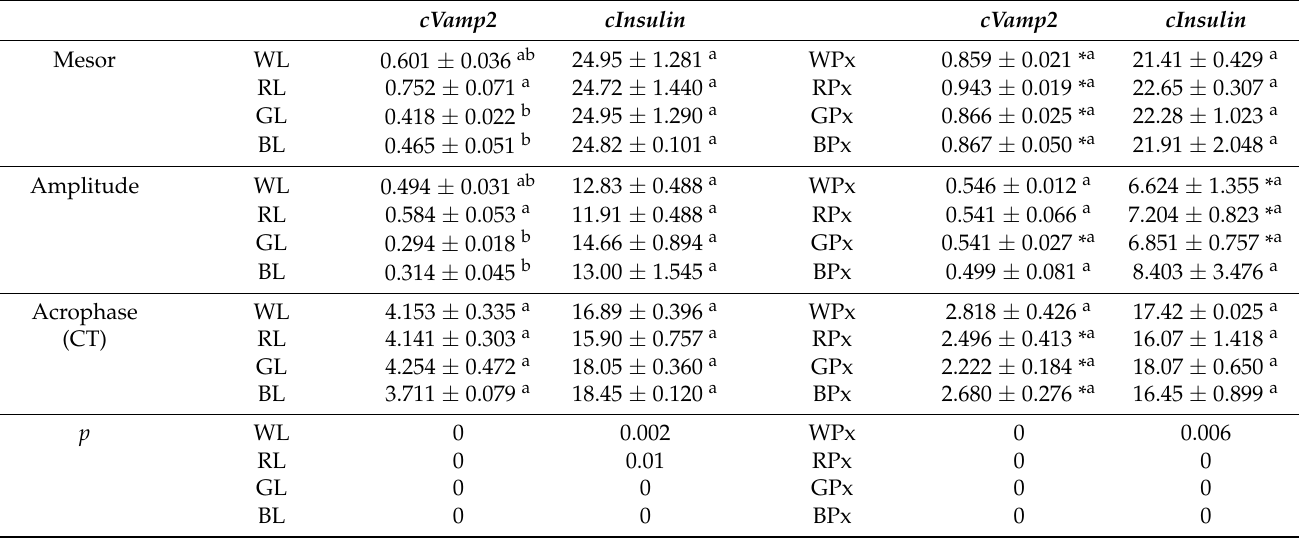
Table 3. The daily temporal difference parameters and circadian rhythm parameters of pancreas cVamp2 and cInsulin transcription under different monochromatic lights in the control and pinealec- tomy